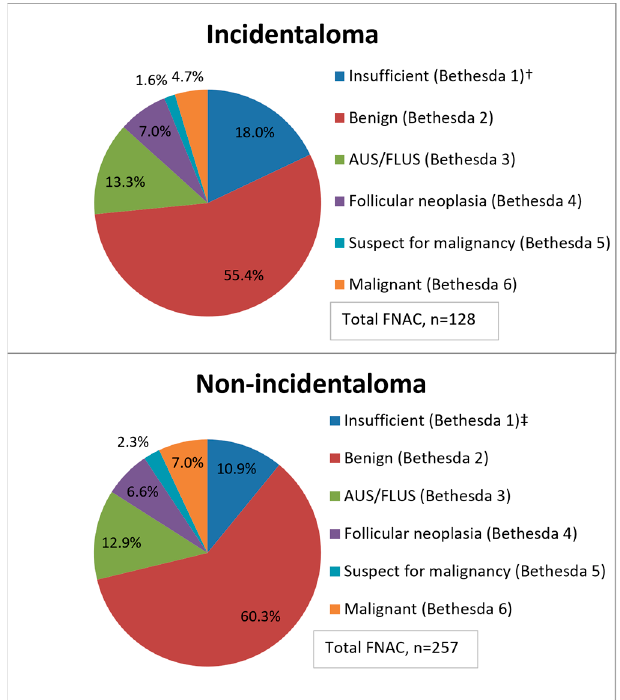
Figure 2. Outcome of FNAC. In case of repeated FNA the highest Bethesda result was considered. The 12 purely cystic nodules in which FNAC was performed for the main purpose of drainage were not included in this analysis. † not including 1 FNAC performed on a cystic lesion. ‡ not including 11 FNAC performed on cystic lesions.